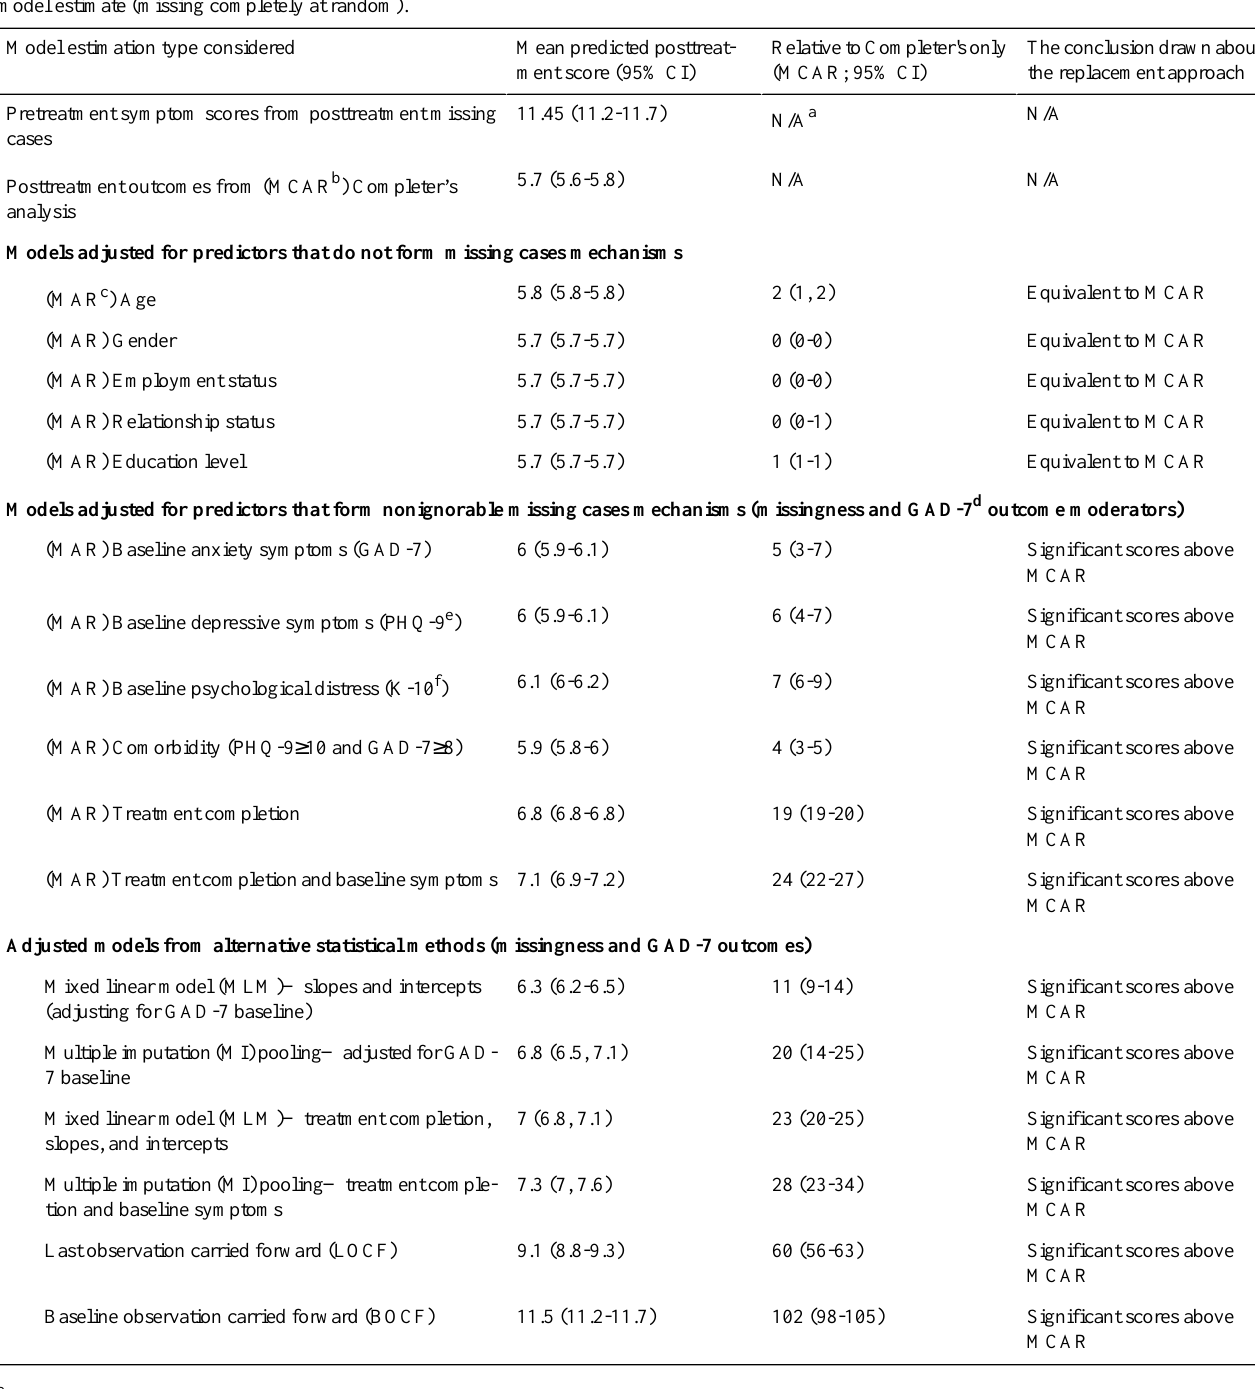
Table 10. Predicted generalized anxiety disorder scale-7 outcomes generated with different replacement models—compared with average posttreatment model estimate (missing completely at random).